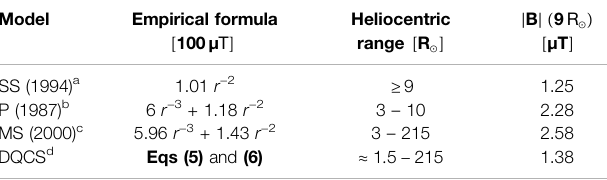
TABLE 2 | Magnetic fi eld strength models used in FR studies, their applicable range, and value at 9 R ⊙ (the approximate heliocentric distance Parker Solar Probe will reach during its closest approach in 2024). Heliocentric distance, r , is given in units of R ⊙